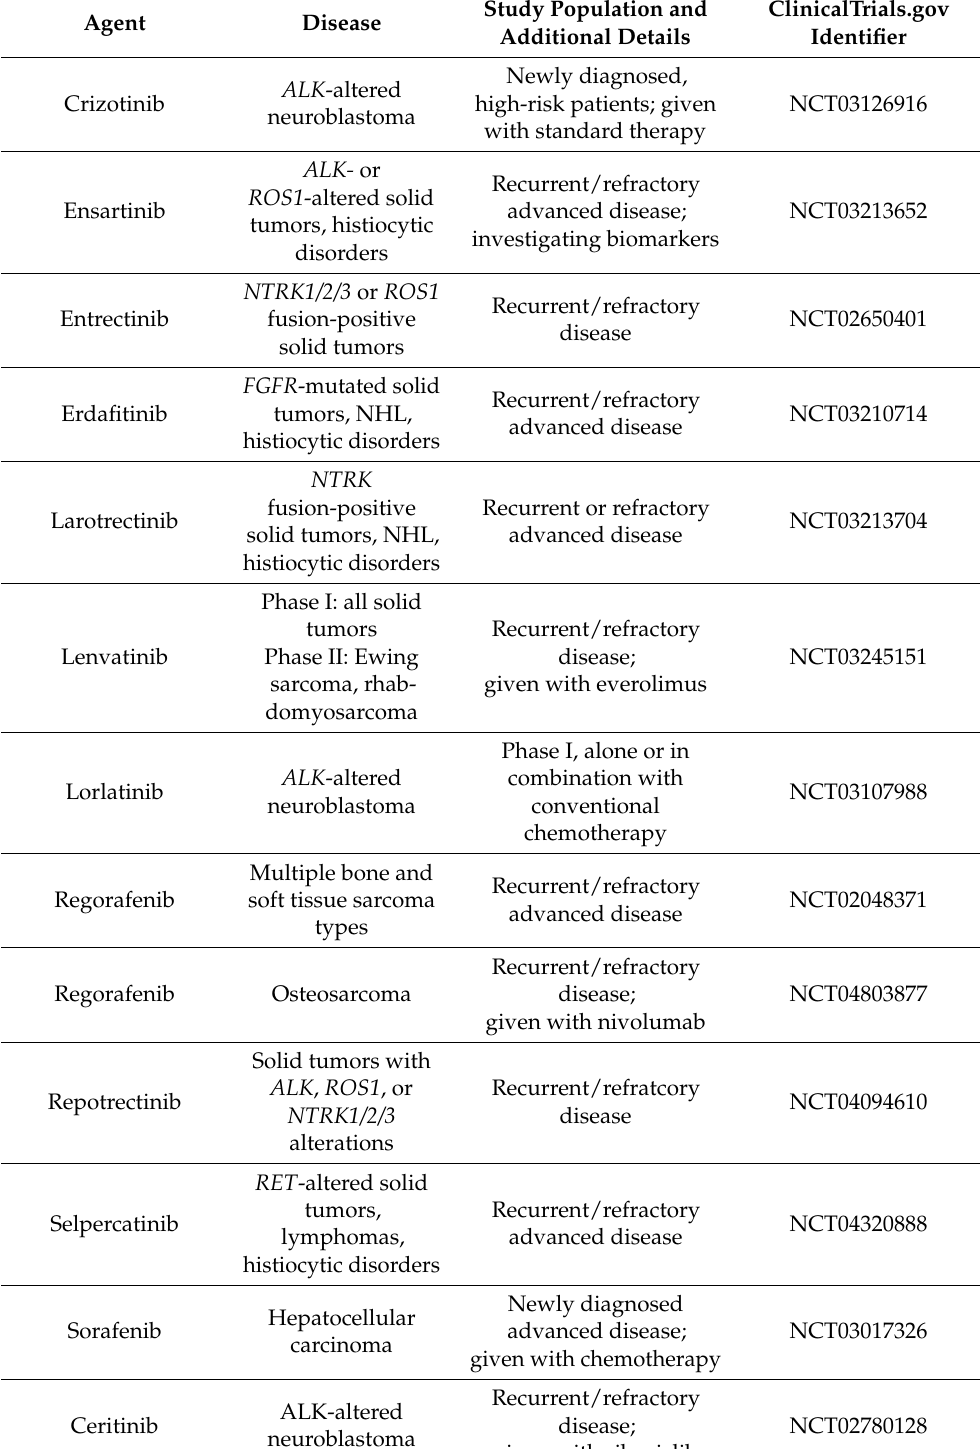
Table 2. Select ongoing clinical trials of receptor tyrosine kinase inhibitors in pediatric solid